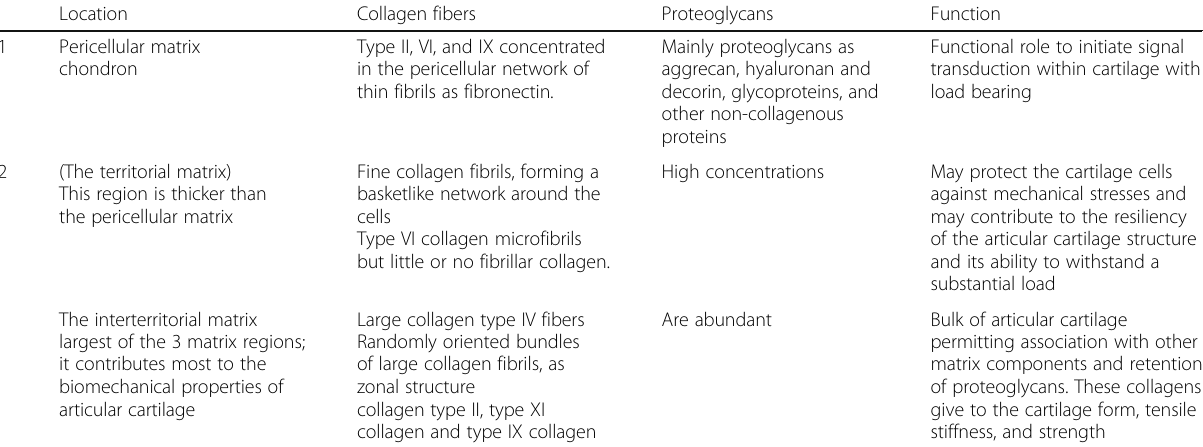
Table 3 Territorial Structure of hyaline articular cartilage [8] Location